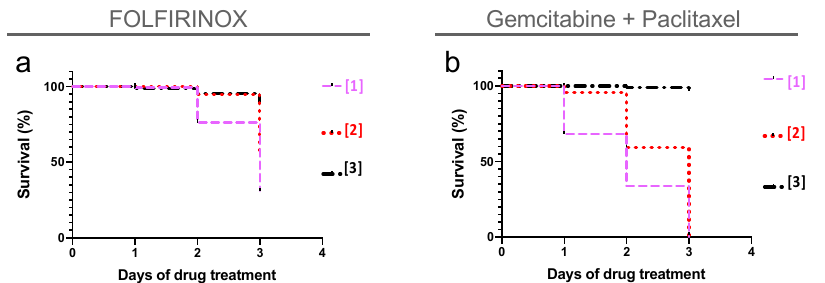
Figure 2. Maximum tolerated concentration (MTC) for FOLFIRINOX and gemcitabine + paclitaxel. Using as a reference the maximum patient’s plasma concentration of each compound (Table S1), we determined the zebrafish MTC. Noninjected embryos with 3 dpf were treated and replaced daily with different doses of chemotherapy for three consecutive days. ( a ) FOLFIRINOX [1] corresponds to 8.4 mM 5-FU + 0.36 mM folinic acid + 0.16 mM oxaliplatin + 0.16 mM irinotecan; FOLFIRINOX [2] corresponds to 6.3 mM 5-FU + 0.27 mM folinic acid + 0.12 mM oxaliplatin + 0.12 mM irinotecan; FOLFIRINOX [3] corresponds to 4.2 mM 5-FU + 0.18 mM folinic acid + 0.08 mM oxaliplatin + 0.08 mM irinotecan. ( b ) GnP [1] corresponds to 3.2 mM gemcitabine + 730 ng/mL paclitaxel; GnP [2] corresponds to 2.4 mM gemcibatine + 547.5 ng/mL paclitaxel; GnP [3] corresponds to 1.6 mM gemcitabine + 365 ng/mL paclitaxel. Due to the reduced mortality, the concentration [3] depicted in black was chosen for both combinations.